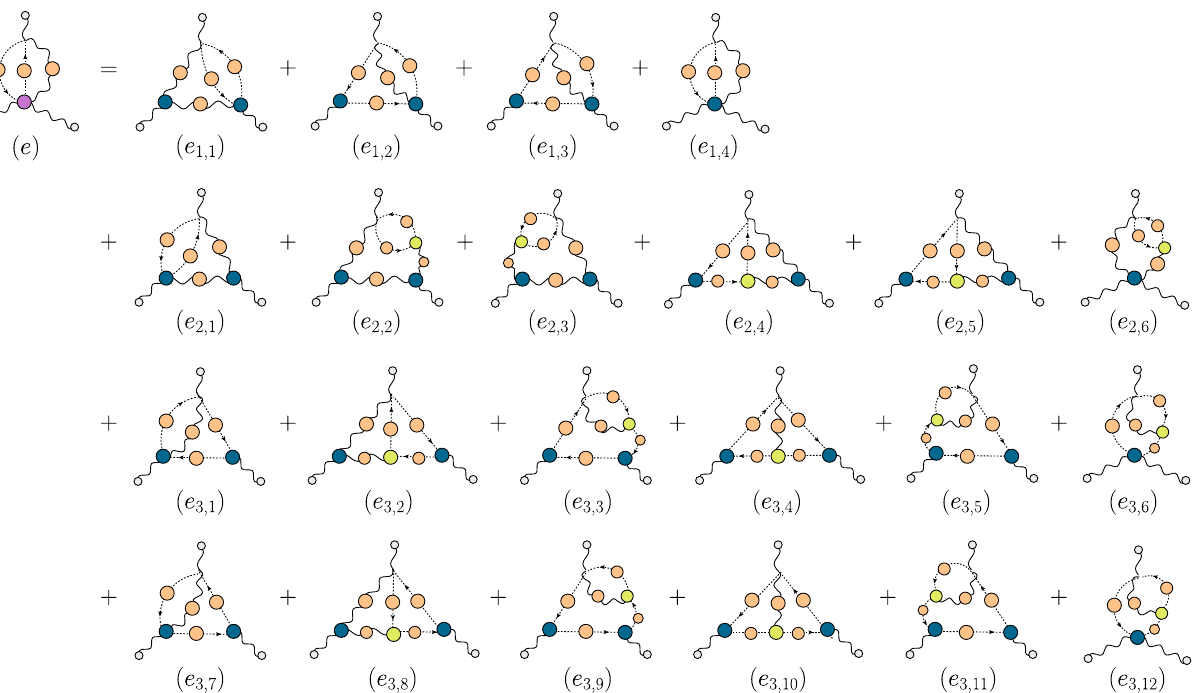
Fig. 6 Contributions from the diagram ( e ) in Fig. 2 after expanding the five-point kernel represented by the purple blob. This group is organized in the three subsets ( e 1 ) , ( e 2 ) , and ( e 3